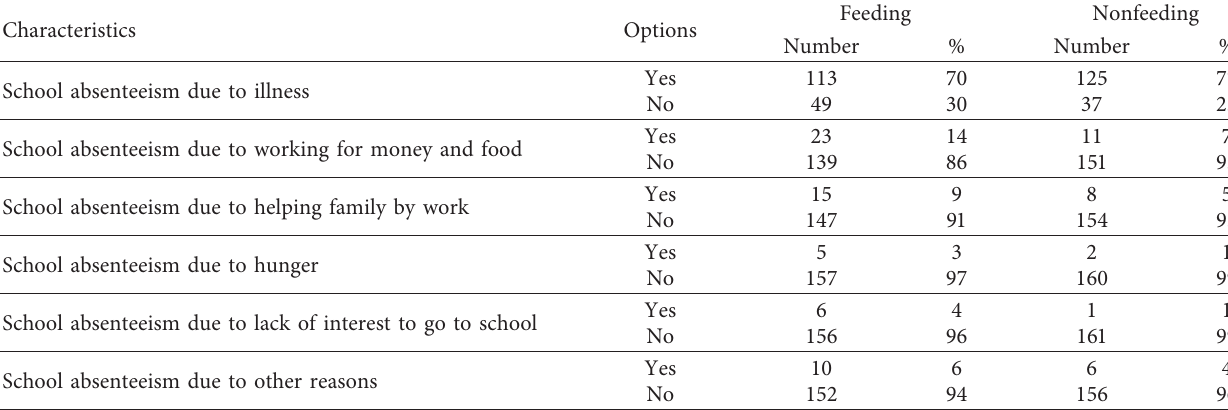
Table 2: School absenteeism and reasons for school absenteeism at selected primary schools in Yeka subcity, Addis Ababa, Ethiopia, August 2018 ( n �